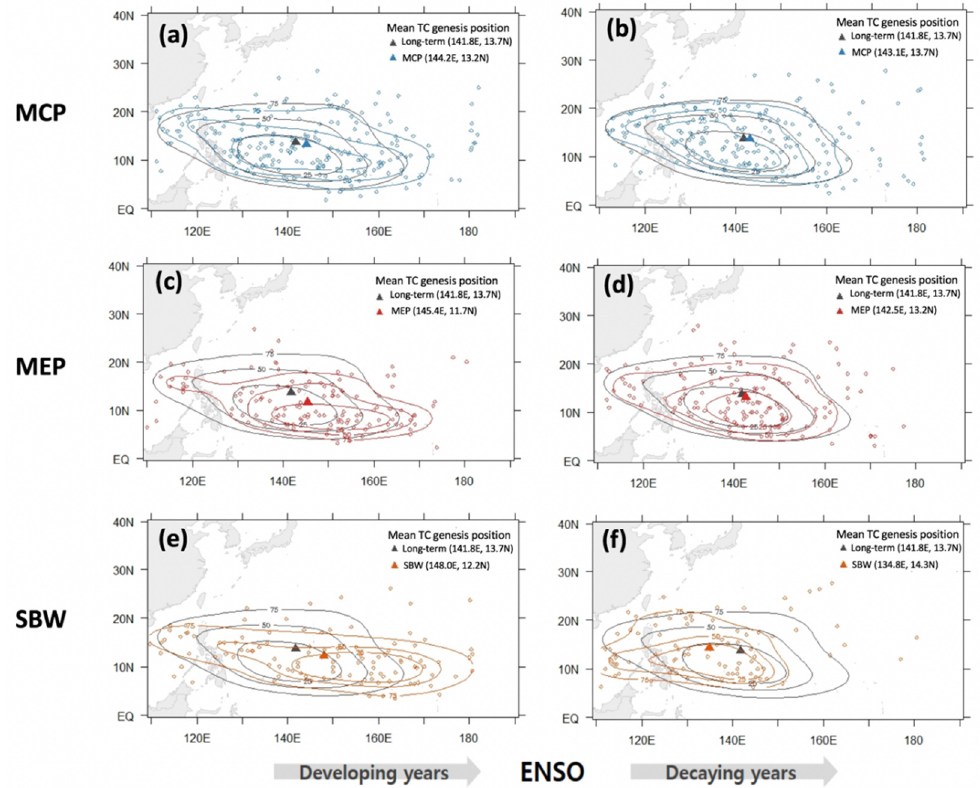
Figure 3. Genesis positions of tropical cyclones (TCs) during the development and decay of mod- erate central Pacific (MCP), moderate eastern Pacific (MEP), and strong basin-wide (SBW) El Niño events. The black contour lines show the long-term trends in TC genesis locations (1961–2017). The TC genesis position is defined as the first location at which a TC was recorded in historical data provided by the Regional Specialized Meteorological Center in Tokyo, Japan. ( a , b ) moderate cen- tral Pacific (MCP); ( c , d ) moderate eastern Pacific (MEP); ( e , f ) strong basin-wide (SBW). Figure 4 shows the density circle of recurving locations during the decay period of three types of El Niño events. Overall, 52, 30, and 14 TCs displayed recurving features (during MCP, MEP, and SBW events, respectively). During SBW events, these points are located close to China, and the contours were wider during MCP events. Recurving points during MEP decay were located in lower latitude zones.